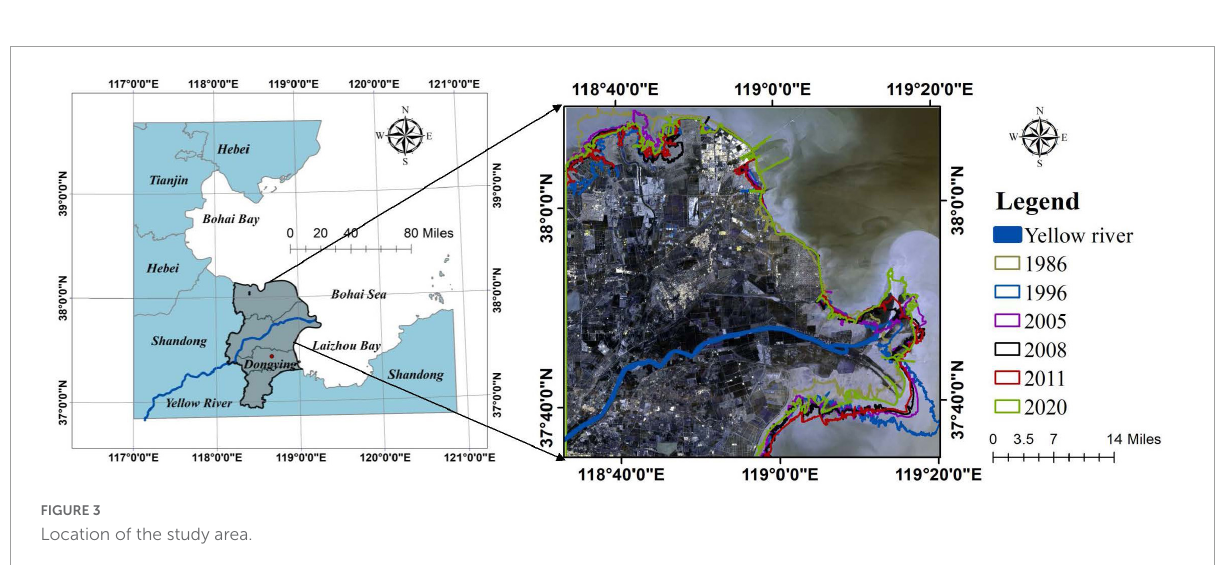
FIGURE3 Location of the study